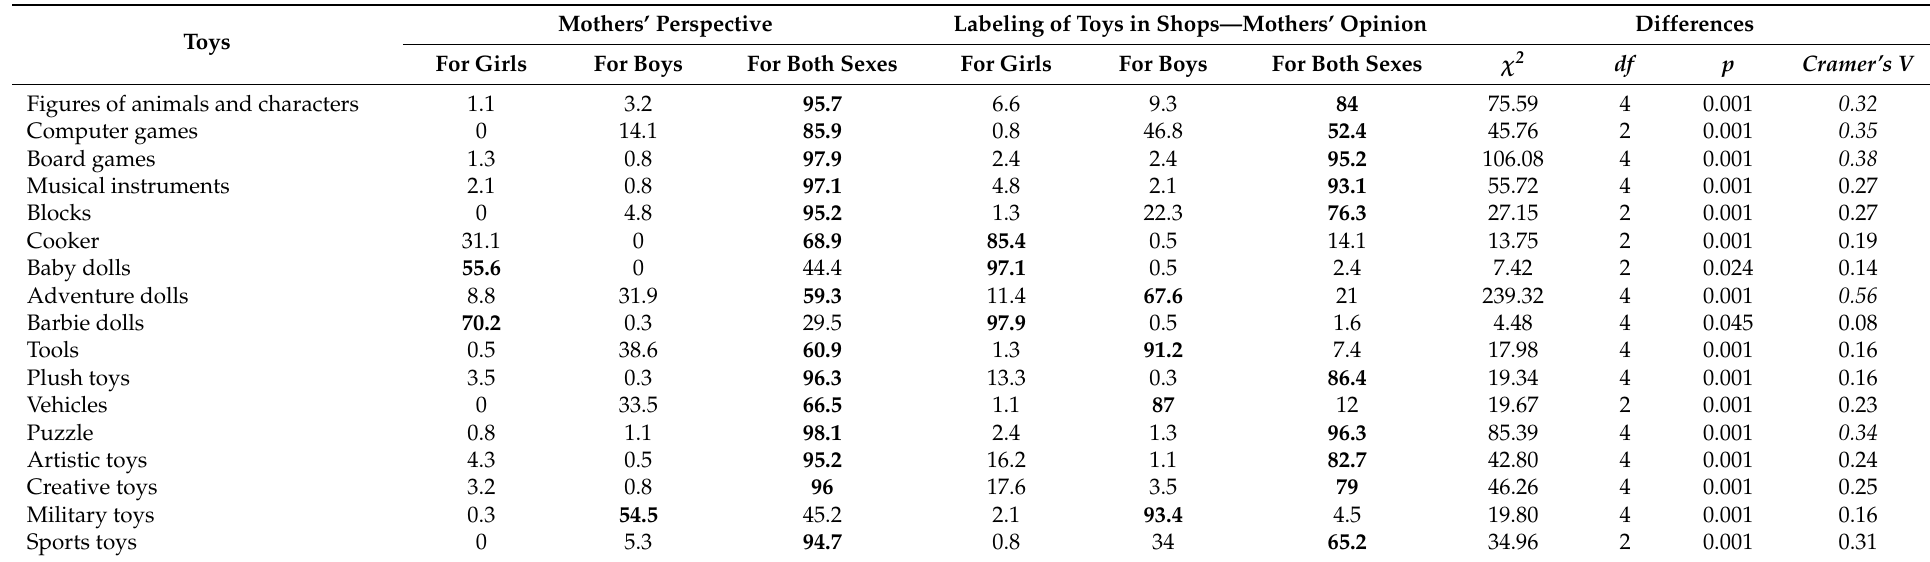
Table 8. Differences between mothers’ perspectives on toys’ appropriateness according to children’s gender and their awareness of labeling of toys in shops according to children’s gender. Mothers’ Perspective Labeling of Toys in Shops—Mothers’ Opinion Differences Toys For Girls For Boys For Both Sexes For Girls For